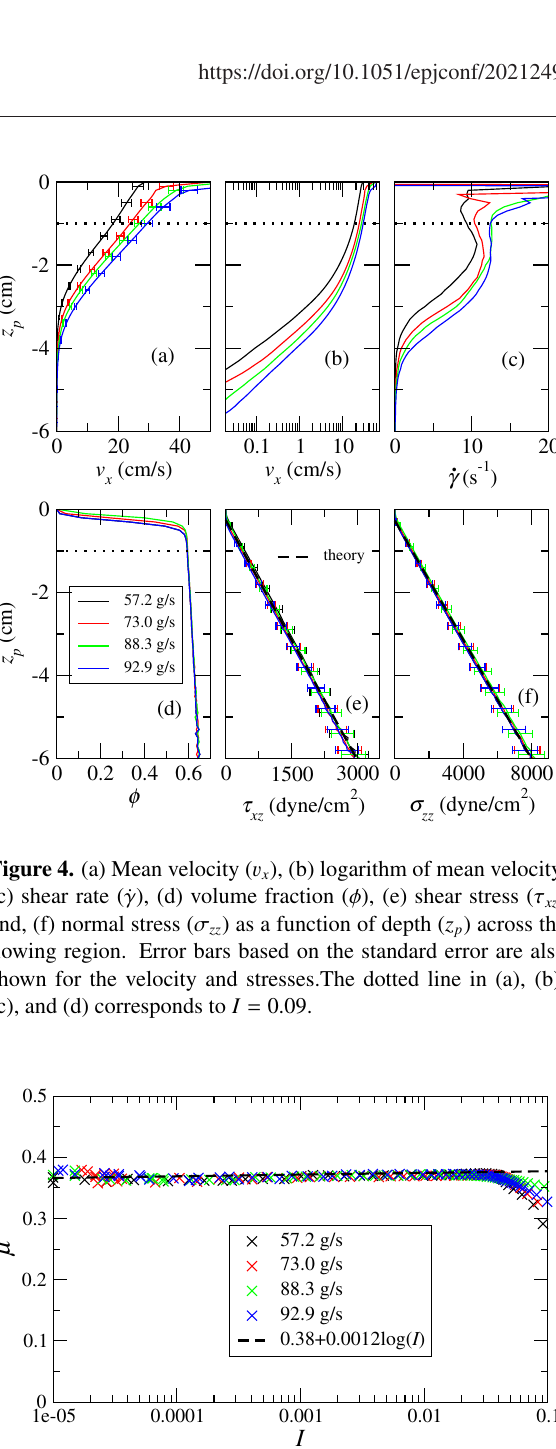
volume fraction at higher Inertial numbers and consequent transition to a kinetic